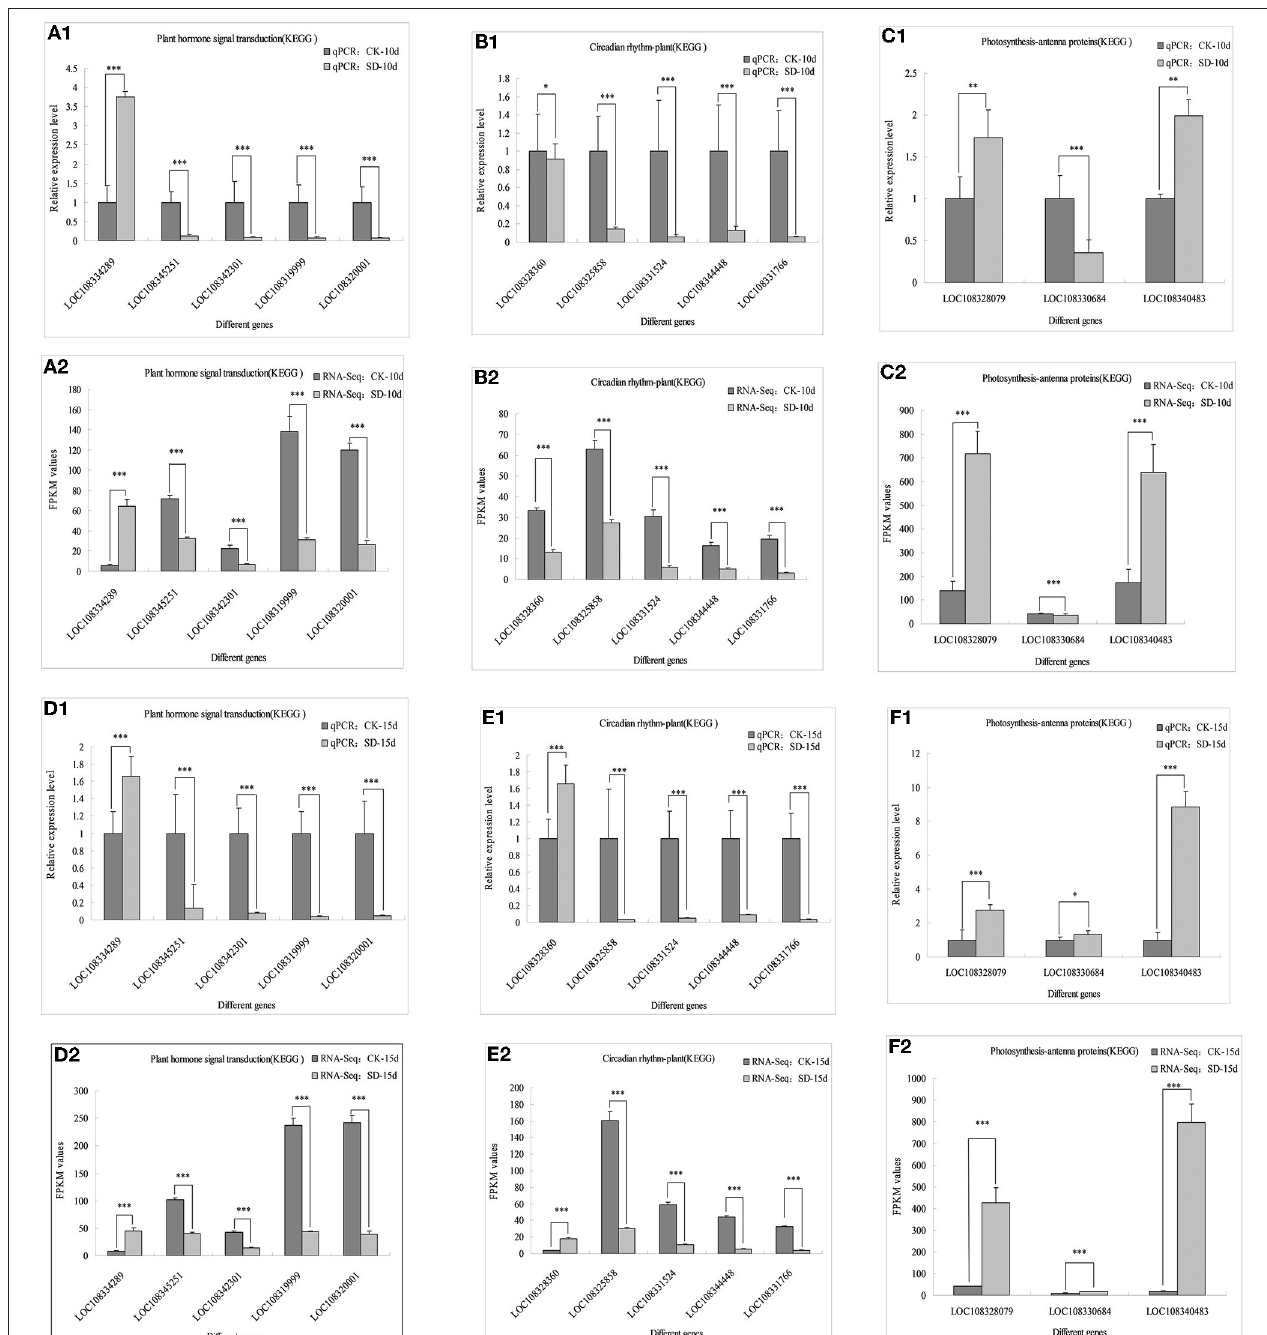
FIGURE 6 | Comparation between qRT-PCR validation and RNA-seq of 13 differentially related photoperiod expressed genes. *Indicates significant difference at 0.05 level, ** and *** indicate extremely significant difference at 0.01 and 0.001 level. (A1–C1) The qPCR validation of 13 genes in three metabolic pathways of plant hormone signal transduction, circadian rhythm and photosynthesis-antenna protein were induced for 10 days under 10 h short-day photoperiod inducement; (A2–C2) RNA-Seq values of 13 genes in three metabolic pathways of plant hormone signal transduction, circadian rhythm and photosynthesis-antenna protein were induced for 10 days under 10 h short-day photoperiod inducement; (D1–F1) The qPCR validation of 13 genes in three metabolic pathways of plant hormone signal transduction, circadian rhythm and photosynthesis-antenna protein were induced for 10 days under 15h short-day photoperiod inducement; (D2–F2) RNA-Seq values of 13 genes in three metabolic pathways of plant hormone signal transduction, circadian rhythm and photosynthesis-antenna protein were induced for 10 days under 15h short-day photoperiod inducement.